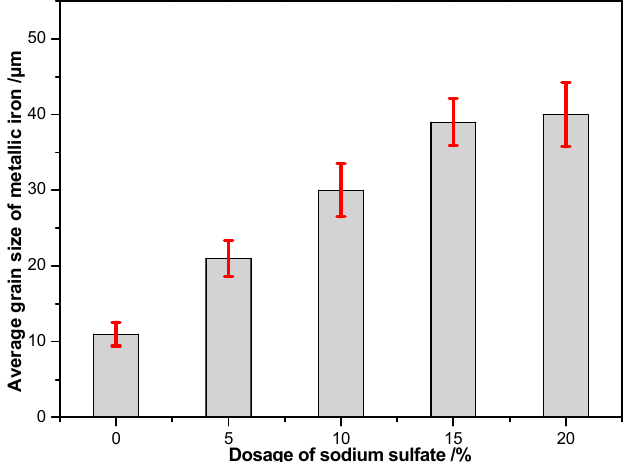
Figure 13. Effect of sodium sulfate dosage on the grain size of metallic iron (Reducing at 1350 °C for 10 min with 2.4 basicity and C/Fe = 0.48).